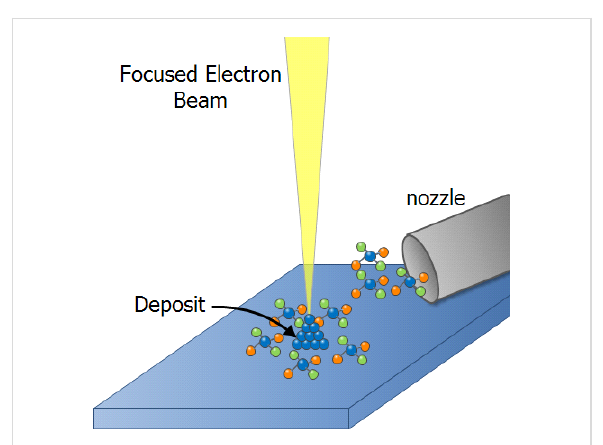
Figure 10: Schematic of electron beam induced deposition